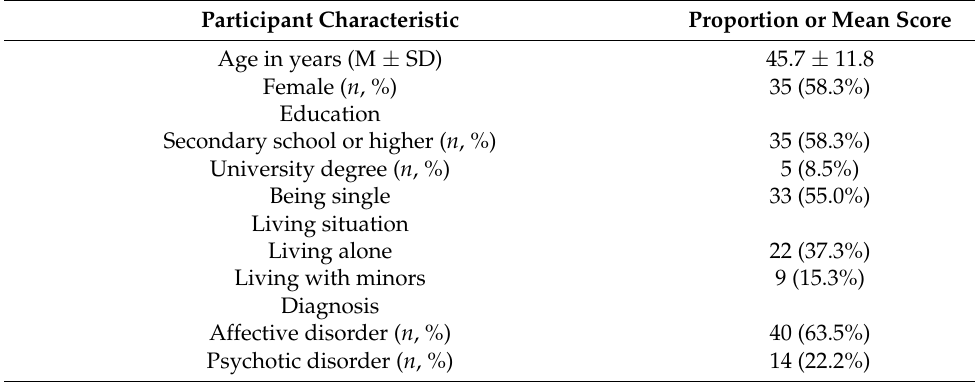
Table 2. Characteristics of 63 participants who consented to participate in the